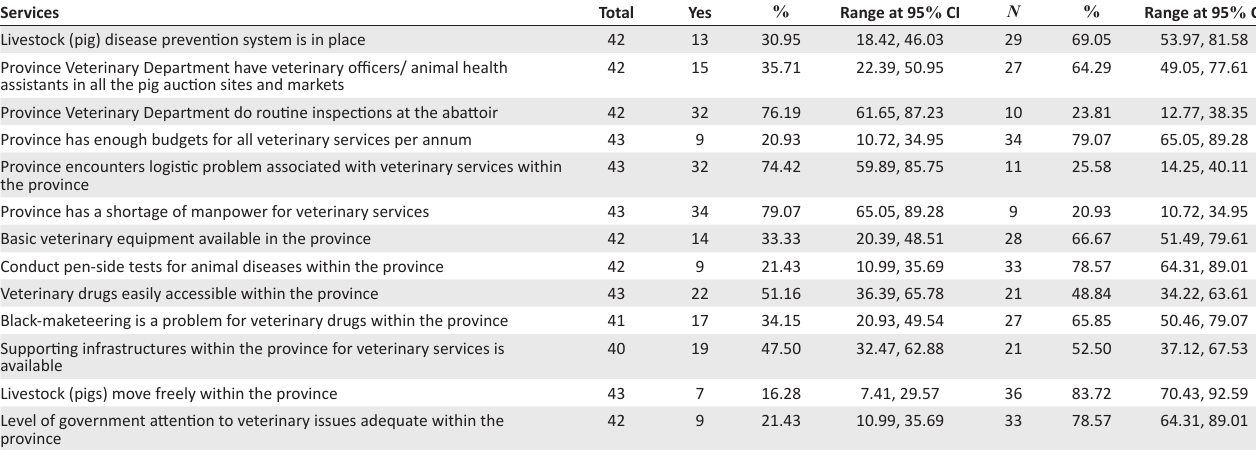
TABLE 1b: Evaluation of pig-related veterinary services within the South African provinces.